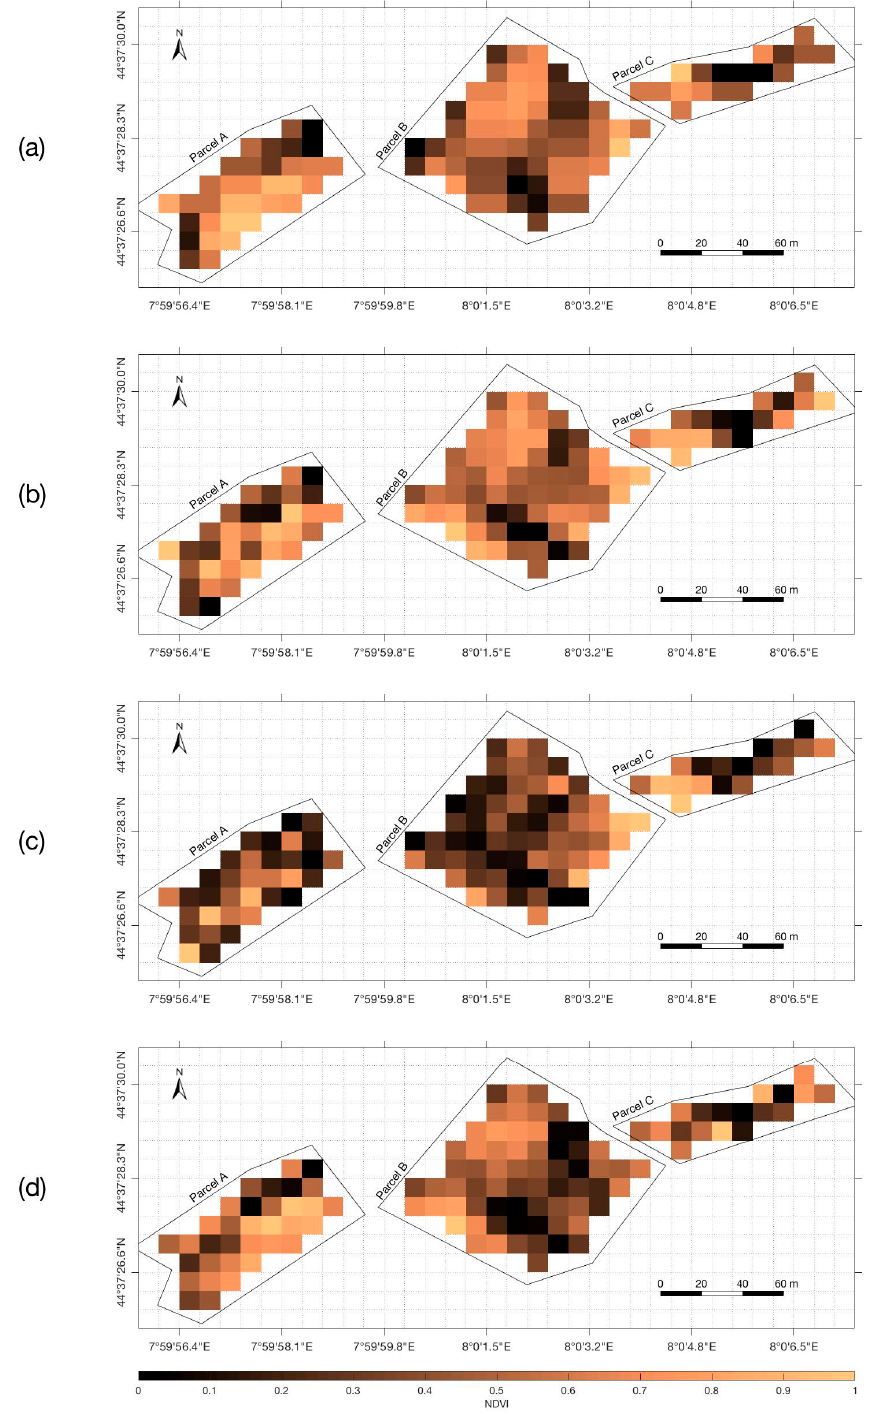
Figure 4. Comprehensive ( a ) NDVI sat map, computed from satellite imagery S 2 , and ( b ) NDVI uav derived from UAV imagery D 2 . ( c ) Enhanced vineyard NDVI vin map, processing UAV imagery D 2 by considering only canopy pixels G vin and ( d ) NDVI int map considering only inter-row surface G int . In all represented NDVI maps, only pixels (i, j) completely included within “Parcel A”, “Parcel B” and “Parcel C” boundaries are shown.